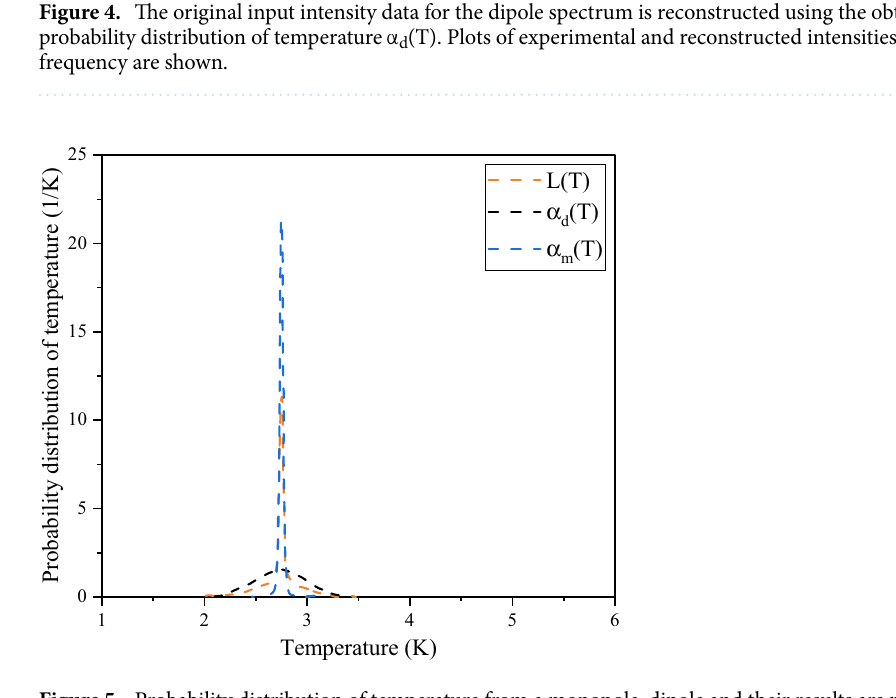
Figure 5. Probability distribution of temperature from a monopole, dipole and their results are plotted against